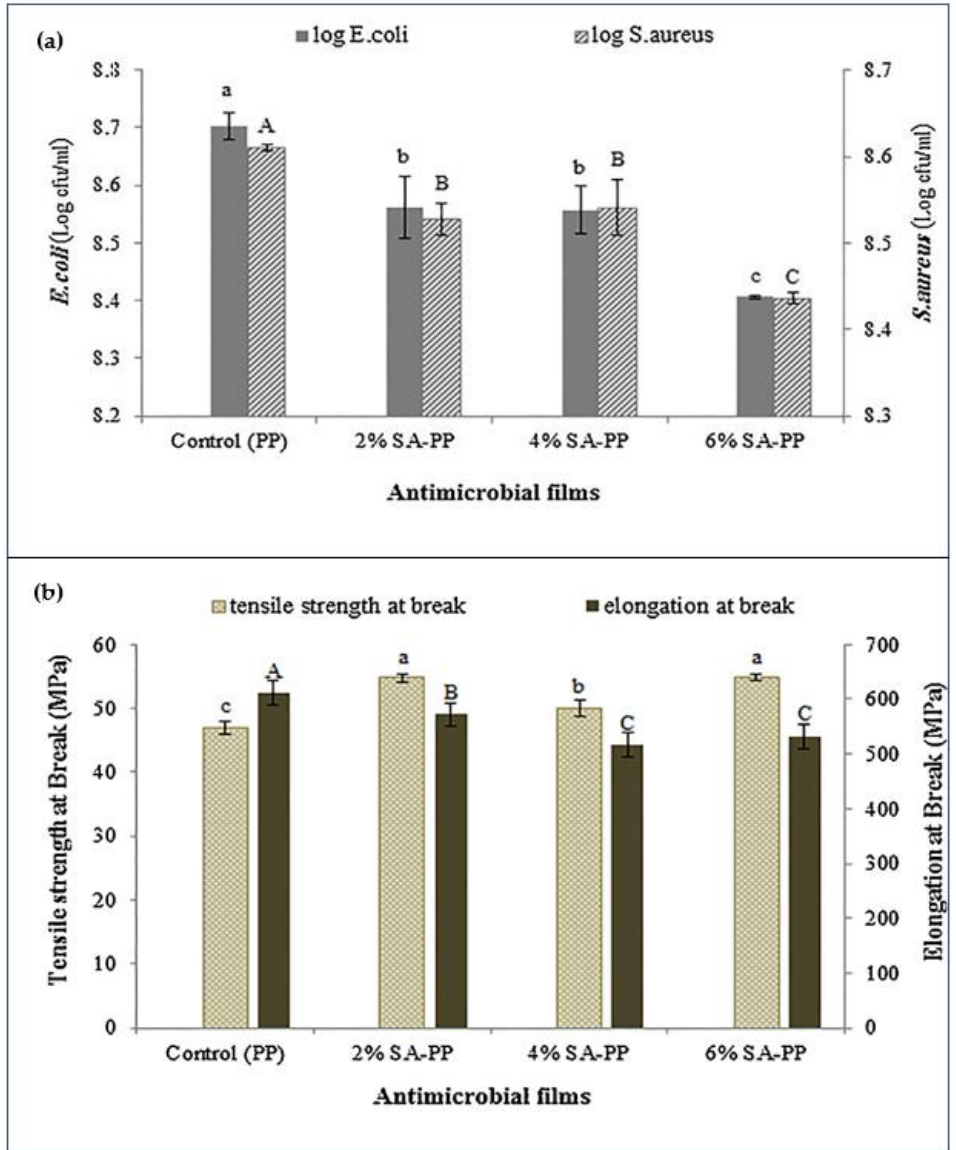
Figure 14. ( a ) Effect of different concentrations of SA on antimicrobial effects ( b ) mechanical properties of SA-PP films. * Small and capital letters represent a significant difference between samples for tensile strength at break (T) and elongation at break (E), respectively (P < 0.05). Reproduced from ref. [121] with permission from Elsevier. 2018 Bacteriocins, such as nisin, have been proposed by many authors for antimicrobial food packaging. Colak et al. prepared nisin-incorporated films by extrusion, blowing, or heat pressing. Nisin-containing films prepared from nisin-containing pellets, either by heat pressing or extrusion blowing at 80 °C for 7 min, exhibited a lower antimicrobial